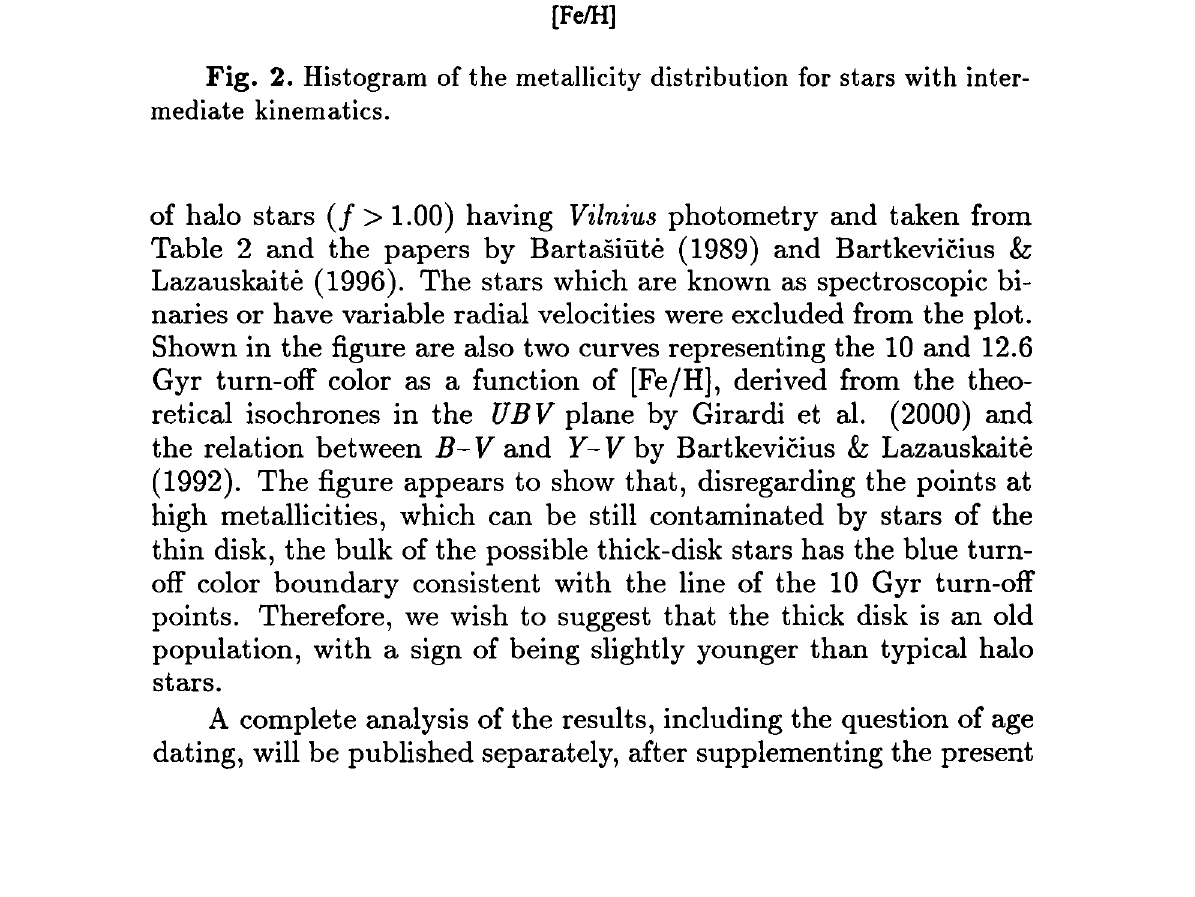
Fig. 2. Histogram of the metallicity distribution for stars with inter- mediate